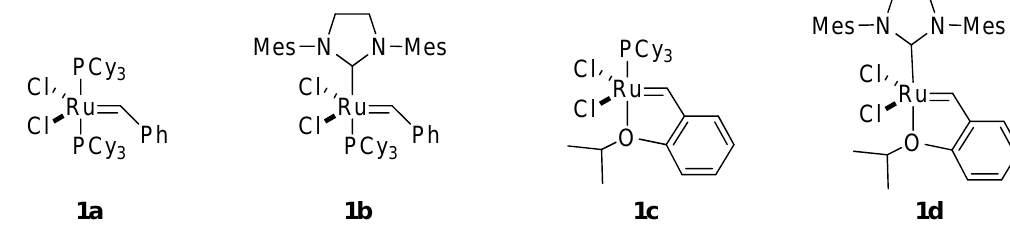
Figure 2. Chemistry of unsaturated 2,3-epoxy